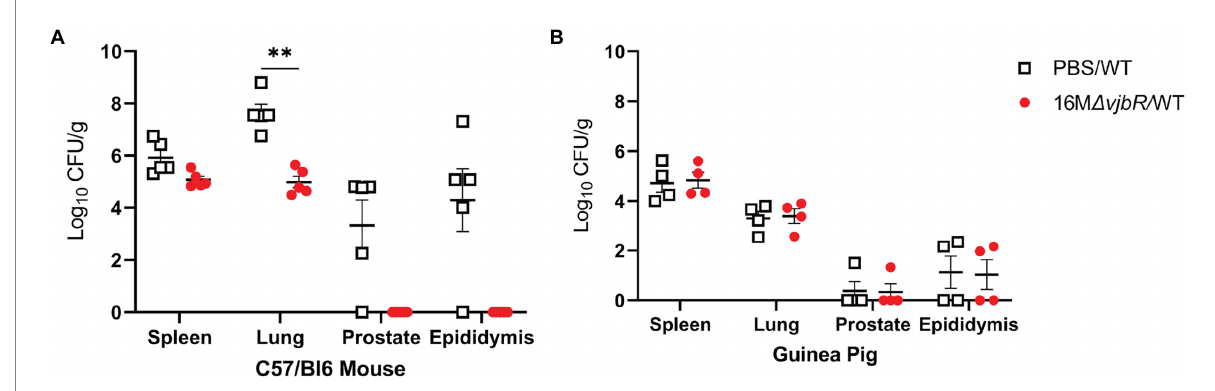
FIGURE 6 Vaccination in mice reduced colonization in the spleen, lung, and reproductive tissues. Mice and guinea pigs were vaccinated with 1×10 9 CFU/100 μ l B. melitensis 16 M Δ vjbR (16 M Δ vjbR /WT) subcutaneously or sham vaccinated with 100 μ l endotoxin-free PBS (PBS/WT) and were challenged IT with 1×10 7 CFU 16 M B. melitensis . (A) Mice ( n = 5) were euthanized 1-week post challenge and spleen, lung, epididymis, and prostate were cultured on Farrell’s media. (B) Spleen, lung, epididymis, and prostate were collected from guinea pigs ( n = 4) at 2-weeks post-challenge and cultured on Farrell’s. Differences in colonization between groups analyzed by multiple Mann Whitney U Test with Sidak-Bonferroni correction. Horizontal bar indicates mean. Results reported as log 10 CFU/g with S.D. ** p <